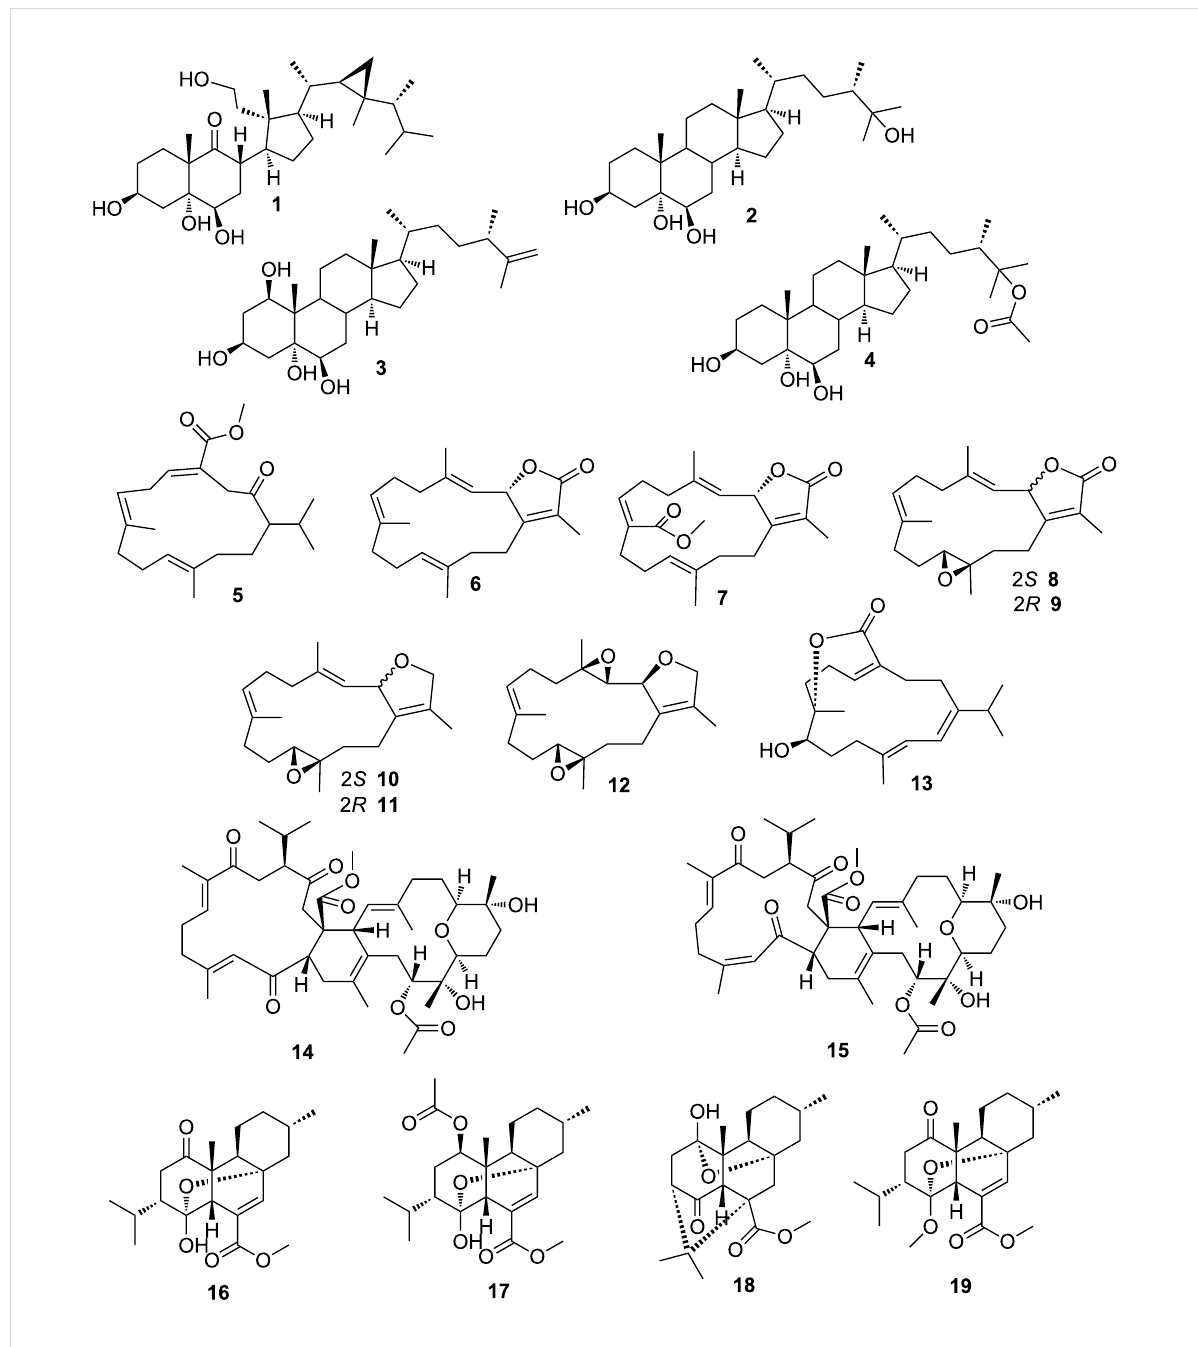
Figure 1: Secondary metabolites isolated in this study from P. longicirrum .